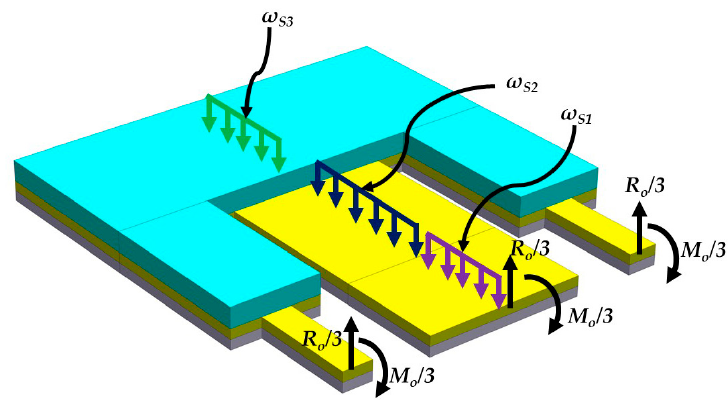
of pVEH microdevice equivalent resonator.